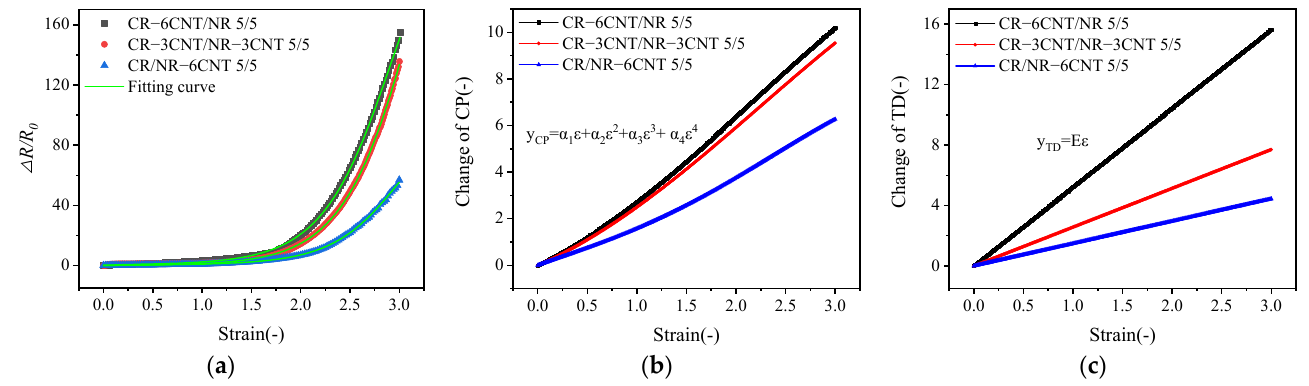
Figure 10. ( a ) Experimental (black, red, and blue dots) and theoretical (green solid line) data for the ∆ R / R 0 − strain curves; ( b ) variation in the conductive path (CP) and ( c ) tunnel penetration distance (TD) versus strain.